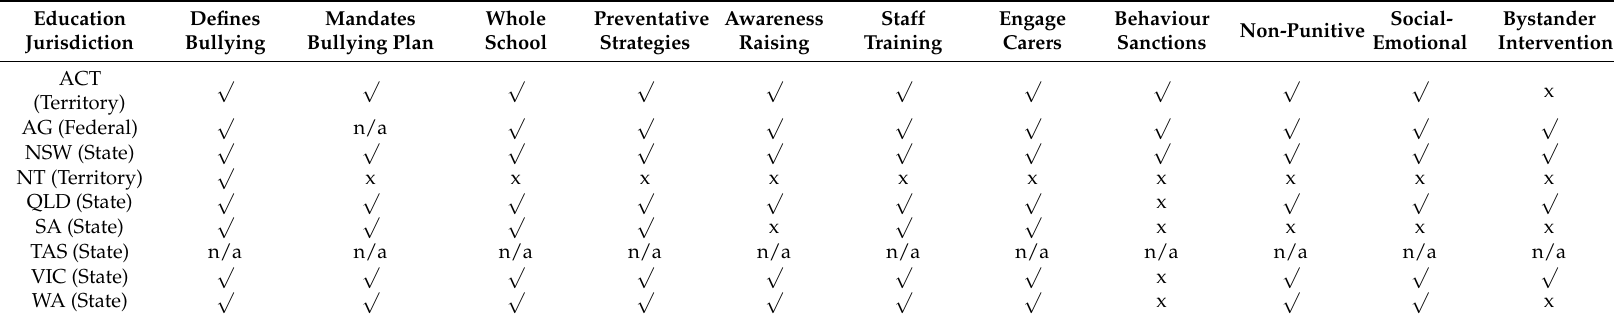
Table 2. Characteristics of Australian anti-bullying programs based on policy and associated